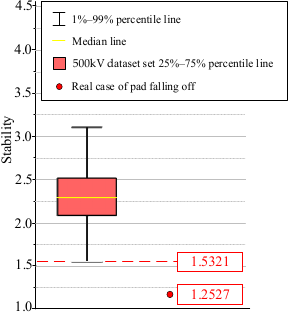
Figure 14. Spectrum distribution diagram of 500 kV dataset under operation status.